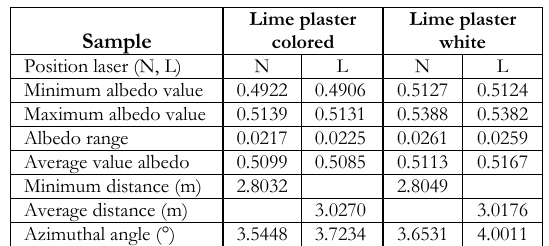
Table 3 - Albedo as a function of the geometric data of survey for each sample The calculation algorithm which considers the values found along the azimuthal range of about 10°, equal zenith angle of 90° has been used for accurate analysis.